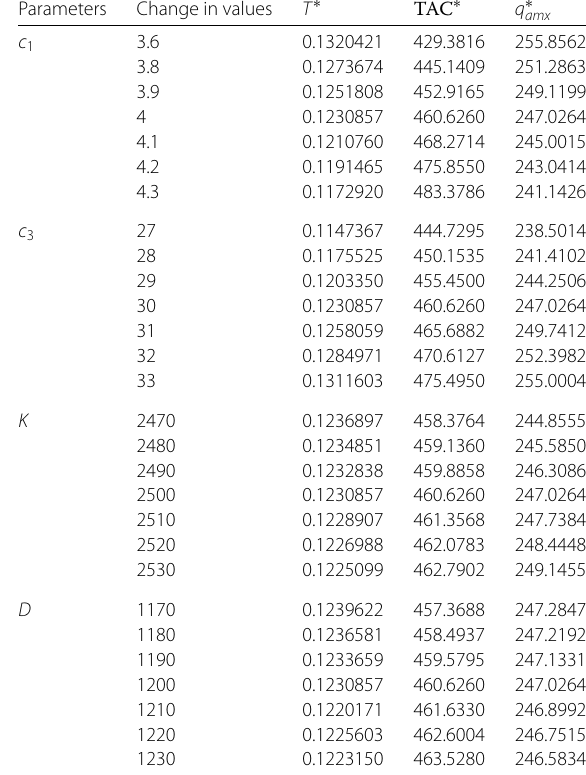
Table 5 Sensitivity table for Case 6.2 for fix α = 0.5 and β = 1